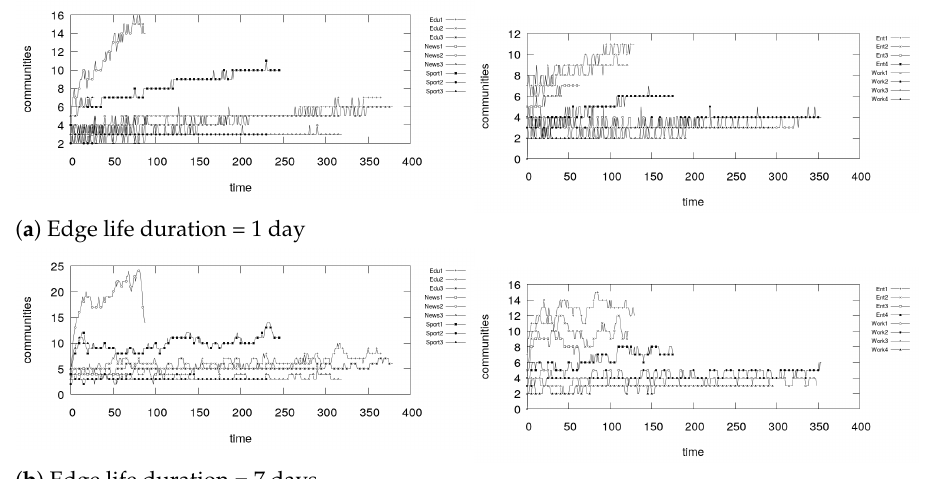
Figure 5. Number of communities detected by K-core.